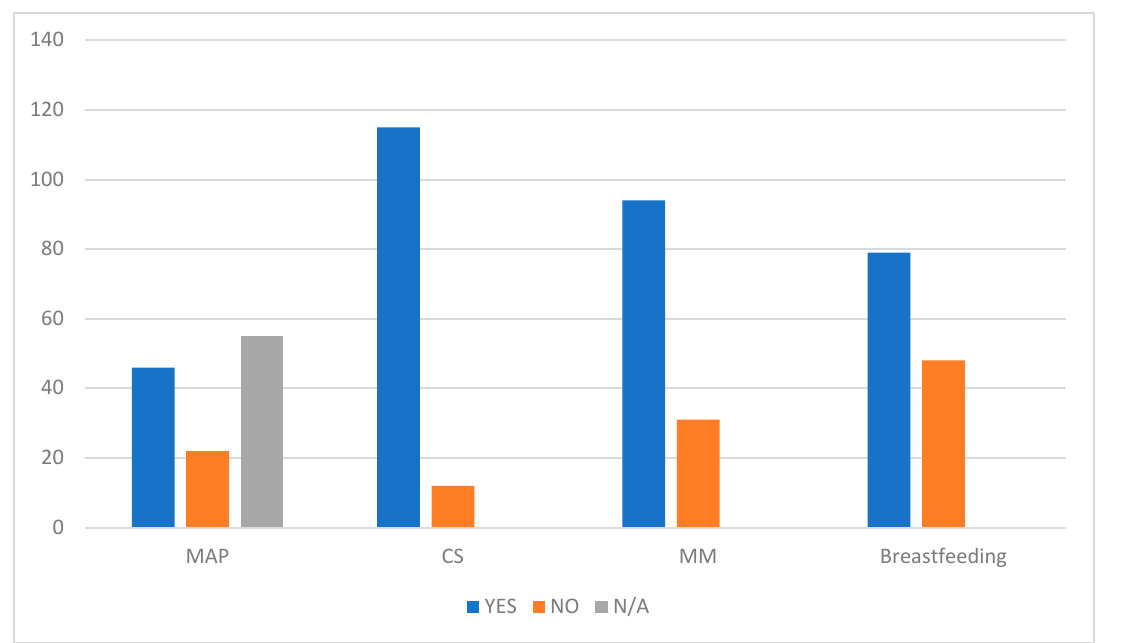
Figure 3. MAP, medically assisted procreation; CS, Caesarean section; MM, maternal milk. Ten (7.87%) newborns weighed < 1000 g (ELBW), 29 (22.8%) < 1500 g (VLBW), and 100 (78.7%) < 2500 g (Table 5, Figure 4). Table 5. Weight and Gestational Age.